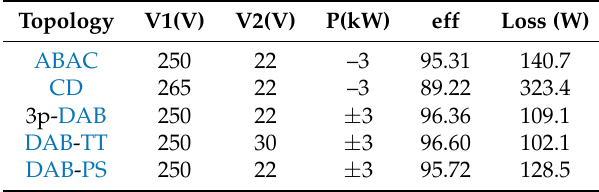
Table 6. Maximum losses for each topology at a specified operating point within the range defined in Table